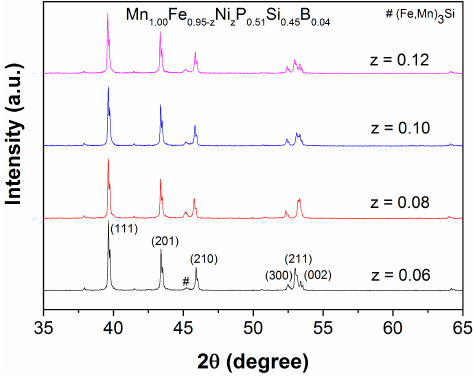
Figure 11. XRD patterns measured at 400 K for the Mn 1.00 Fe 0.95 − z Ni z P 0.51 Si 0.45 B 0.04 compounds. The magnetization versus temperature curves of the Mn 1.00 Fe 0.95 − z Ni z P 0.51 Si 0.45 B 0.04 compounds